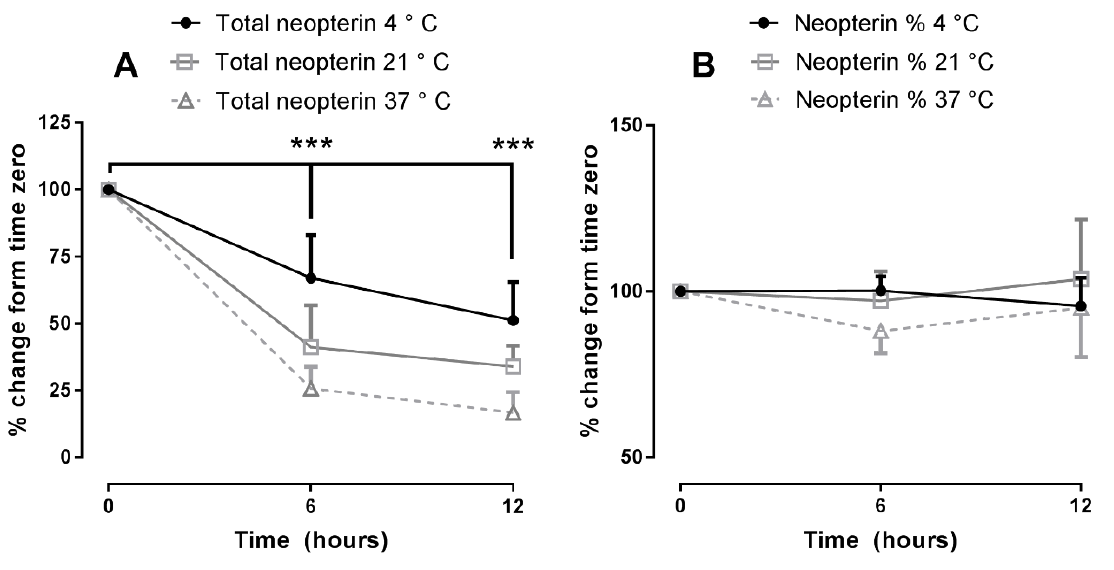
Figure 3: Stability of plasma 7,8-dihydroneopterin (A) and neopterin (B). Plasma 7,8-dihydroneopterin (measured as total neopterin) shows a significant decrease over all temperatures at 6 and 12 hours. Data is presented as means with SD. ***p<0.001.